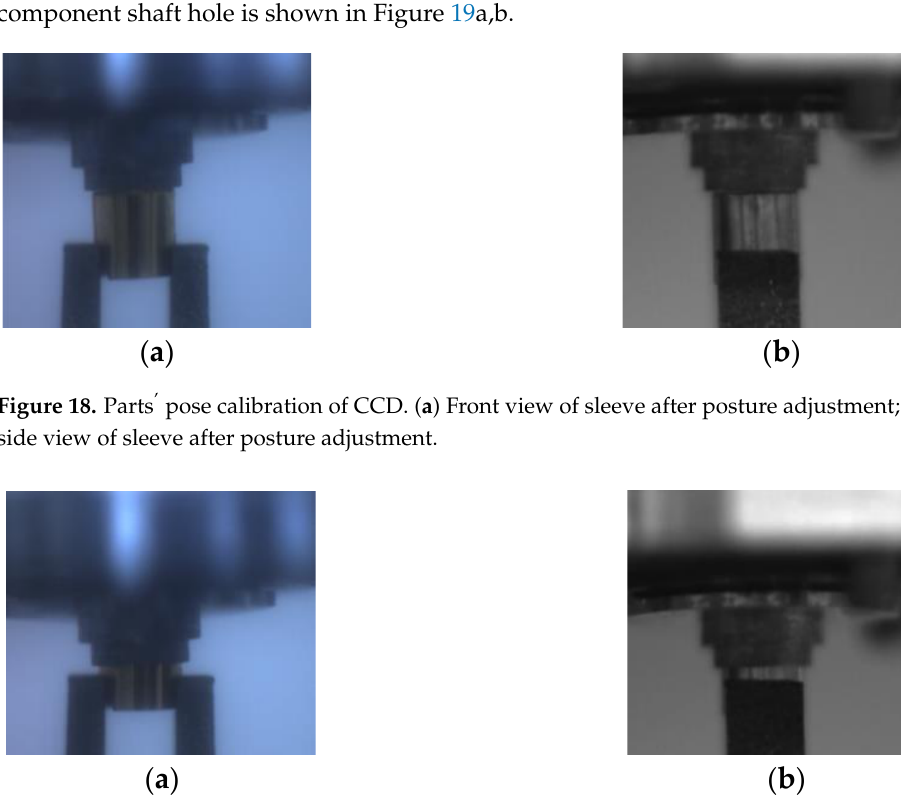
Figure 17. Size calibration of CCD. ( a ) Draw lines on the sleeve to mark its frontal posture; ( b ) Draw